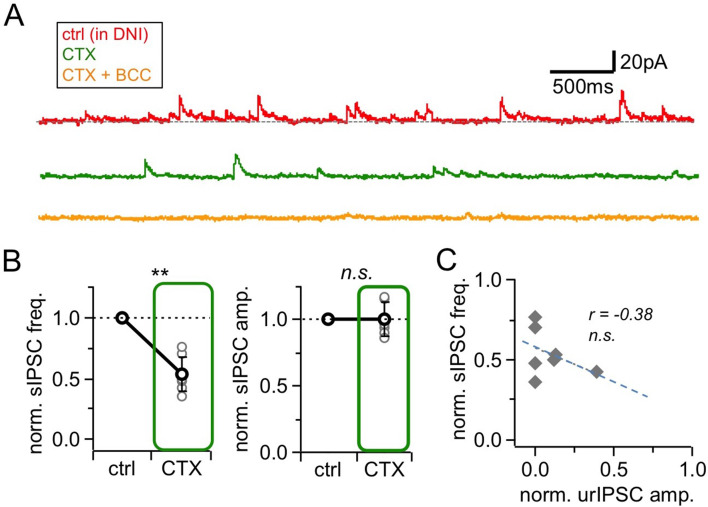
Effects of HVACC blockade by ω-conotoxin MVIIC (CTX, 1 μM) on spontaneous activity.(A) Representative experiment showing voltage-clamp recordings (+10 mV) from a mitral cell in the presence of DNI (control, top trace), upon addition of CTX (middle trace) and further wash-in of BCC (50 µM; bottom trace). (B) sIPSCs in control and in presence of CTX (n = 7 MCs). Left: Frequency. Right: Amplitude. sIPSCs were abolished in BCC (analysis not shown) (C) Linear regression between the CTX effect on sIPSC frequency vs urIPSC amplitude (n = 7 MCs). No significant correlation.